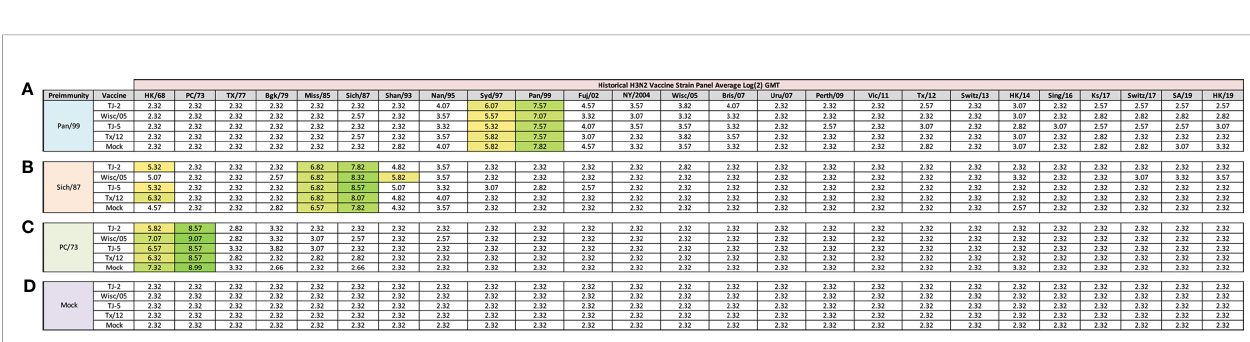
FIGURE 2 | Day 13 H3N2 Historical Vaccine Strain HAI Panel. Serum collected from animals 14 days post infection was analyzed for HAI activity against a panel of historical H3N2 in fl uenza vaccine strains spanning 1968-2019. Table is divided into sections based on the virus each animal received to establish preimmunity: A/ Panama/2007/1999 (A) , A/Sichuan/2/1987 (B) , A/Port Chalmers/1/1973 (C) , or PBS (Mock) (D) . Cells in table are color coded as a heat map based upon Log(2) HAI geometric mean titer (GMT) for each group of ferrets (N=4). The heat map colors cells yellow at a Log(2) GMT of 5.32 which correspond to an HAI titer of 1:40, and cells become a darker shade of green as the average antibody titer of the group increases. Cells with no correspond to groups that did not achieve a GMT ≥